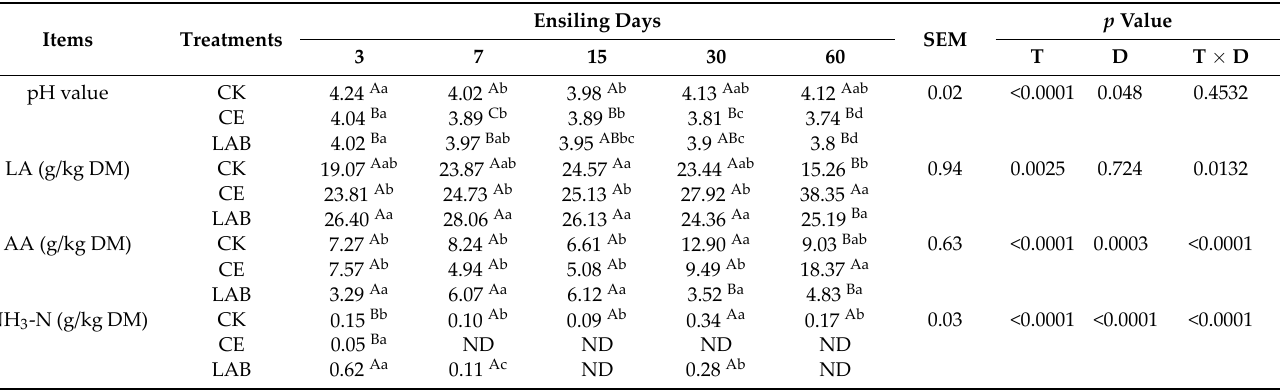
Table 2. Effects of additives and ensiling days on fermentation parameters of Caragana korshinskii silage.